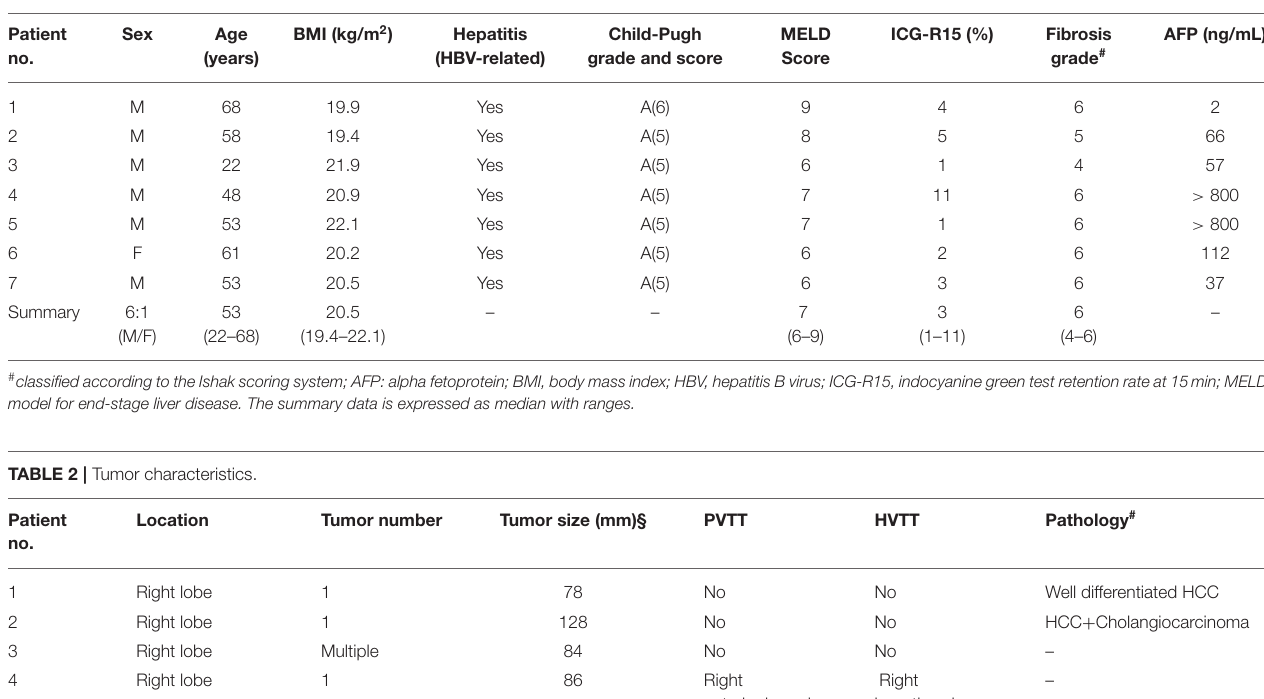
TABLE 1 | Basic information of the